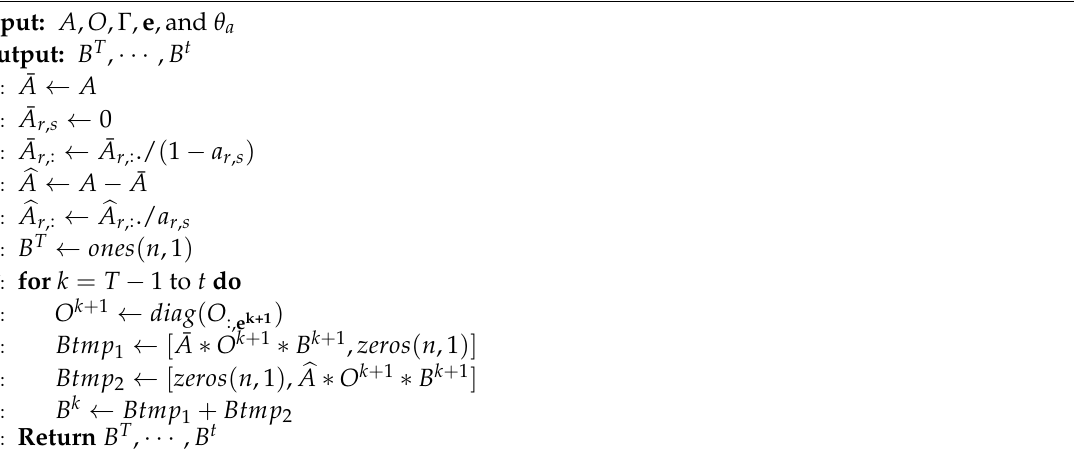
Algorithm 4 This computes the coefficients of the backward probability sensitivity function | x t )( θ ) in backward matrices B k for k = T , · · · , t using p ( y t + 1: T a v e